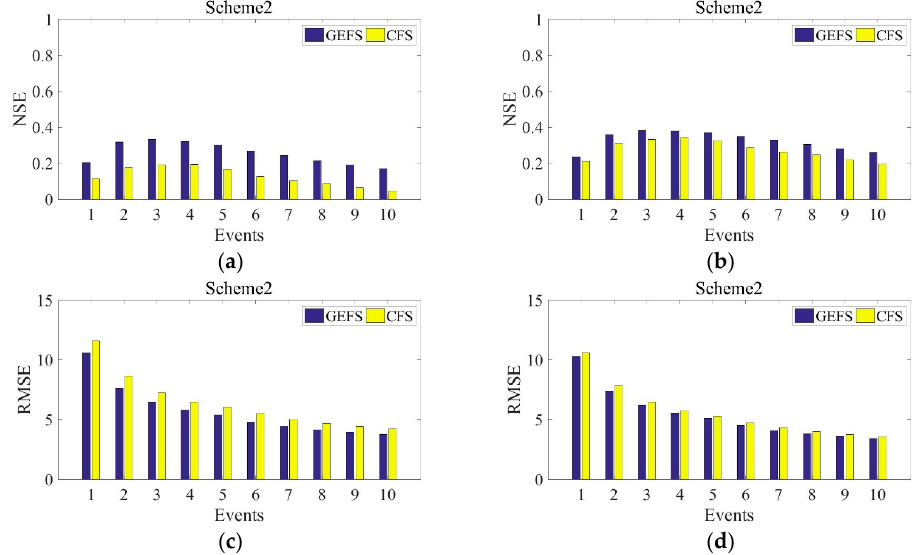
Figure 5. The evaluation results of Scheme 2: ( a ) the NSE of raw forecasts; ( b ) the NSE of post-processed forecasts; ( c ) the RMSE of raw forecasts; and ( d ) the RMSE of post-processed forecasts.